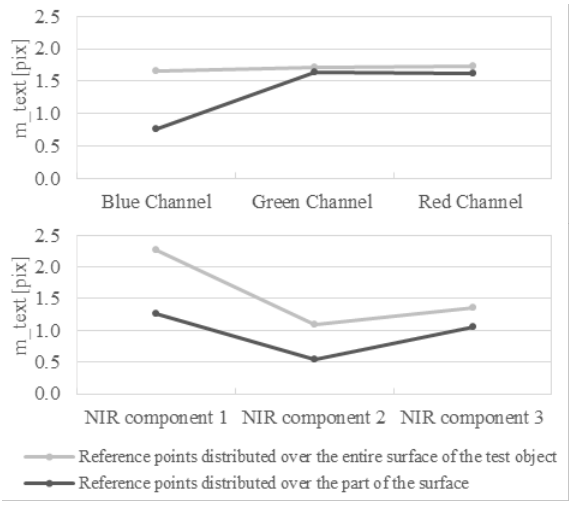
Figure 3. Summary of the mean errors of texturing for RGB and NIR imagery for different distribution geometries of matching points